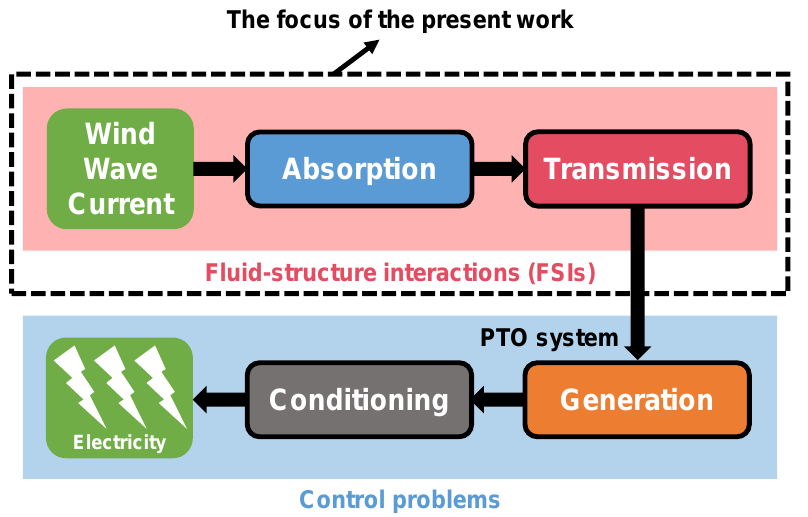
Figure 2. The working pipeline of a generic OED (adapted from [17]), and the focus of the present